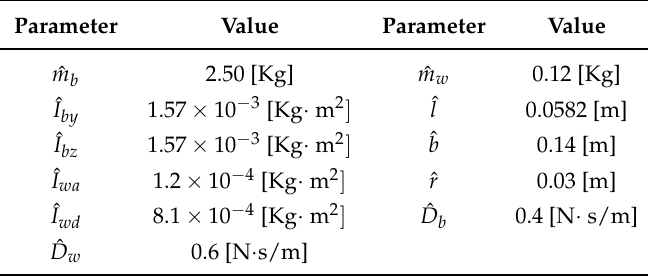
Table 2. Nominal parameters of the MWIP